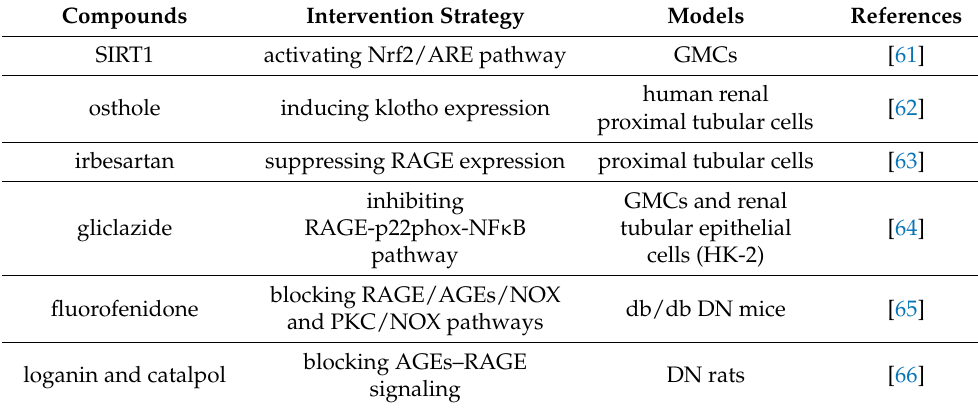
Table 2. Pharmacotherapeutic targets in DKD and the aging kidney [60]. Compounds Intervention Strategy